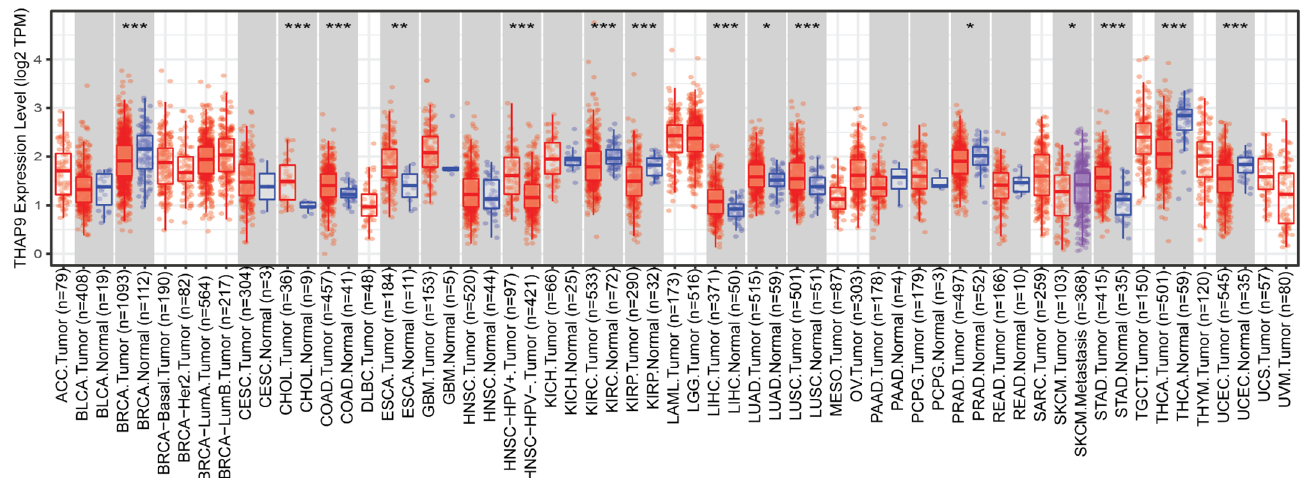
Figure 5. THAP9 gene expression levels in different tumors. THAP9 expression levels in human tumors (red) and corresponding normal tissues (blue) were obtained through TIMER2. The statistical significance computed by the Wilcoxon test is annotated by the number of stars (*: p -value < 0.05; **: p -value < 0.01; ***: p -value < 0.001).